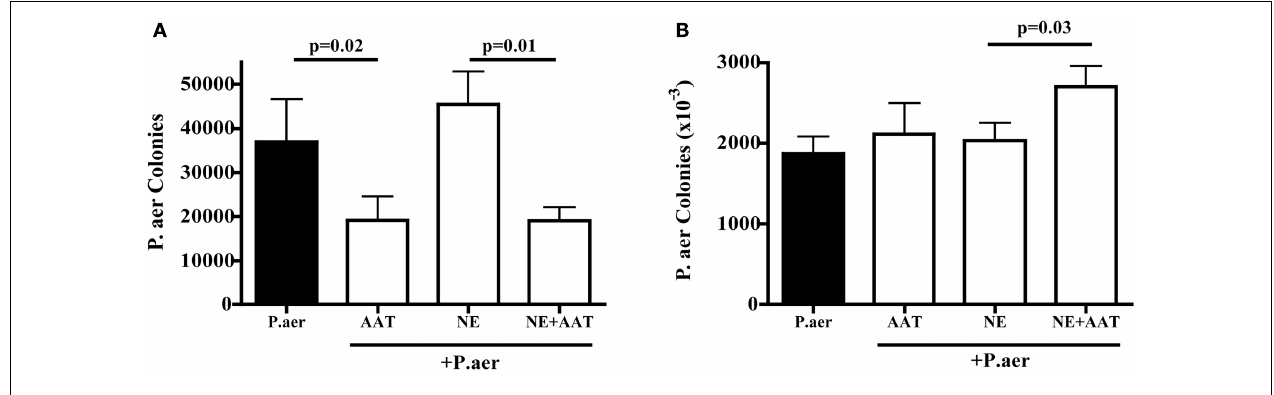
surface adhesion experiments (B) , A549 cells were lysed and concentrations of released bacteria calculated after culture on LB-agar plates. p -Values are indicated in the graphs. Data are depicted as means + SEM of bacterial colonies.